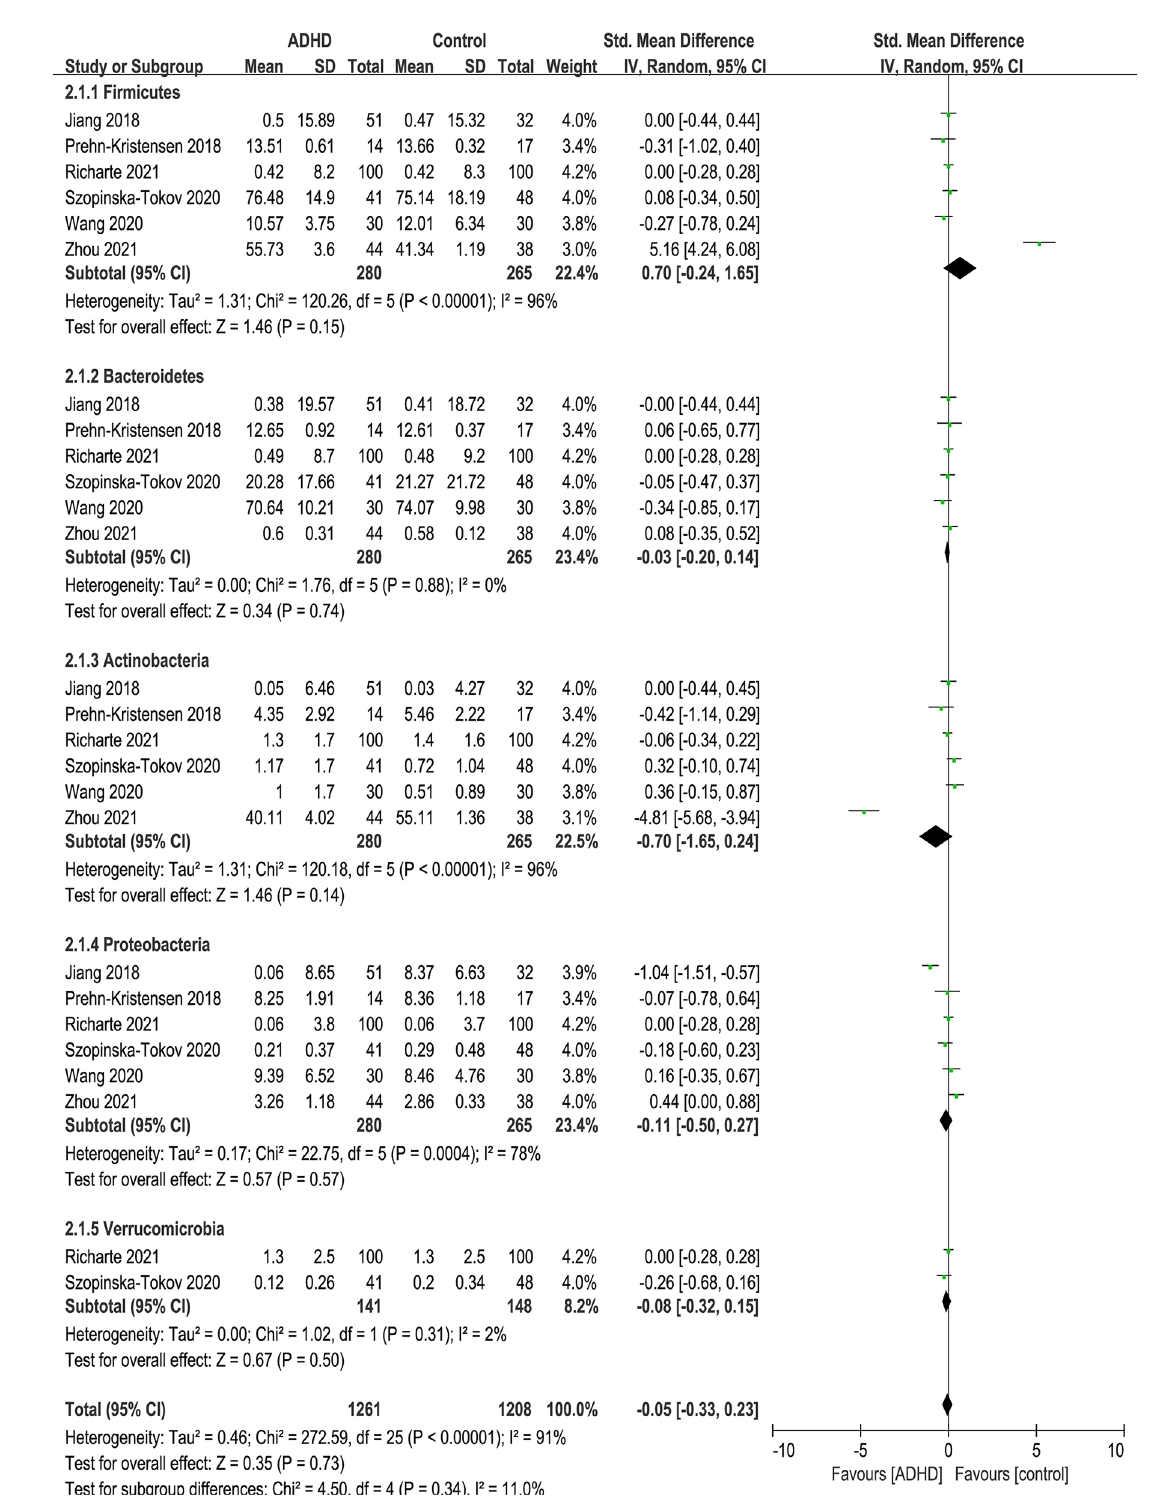
Frontiers in Endocrinology |